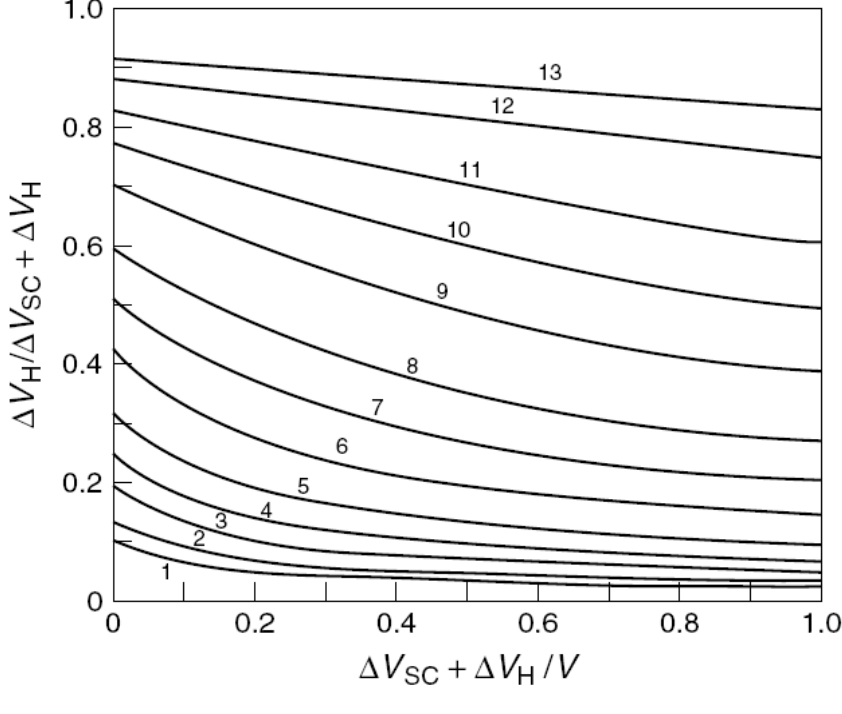
Figure 8. The ratio of the potential drop in the Helmholtz to the total potential change computed as a function of the total potential change. A static dielectric constant of 173 (typical of TiO ) and a Helmholtz capacitance of 10 µF/cm 2 were assumed and the doping 2 density was allowed to vary from 10 16 cm −3 (curve 1) to 10 20 cm −3 (curve 13) (adopted from Ref.